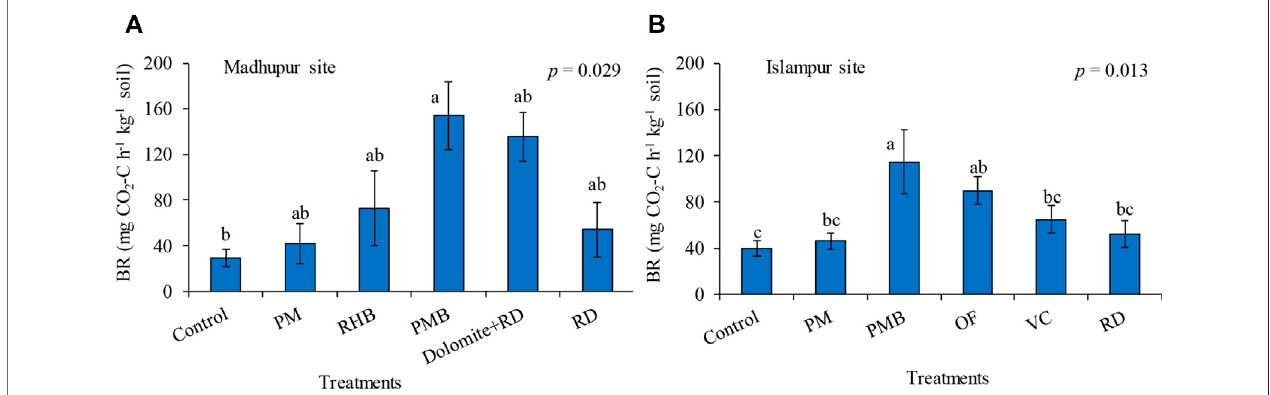
FIGURE 2 | Effects of different organic and inorganic treatments on basal respiration at Madhupur site (A) and Islampur site (B) . Data are average ± SE ( n (cid:2) 4); PM (cid:2) poultry manure, RHB (cid:2) rice husk biochar, PMB (cid:2) poultry manure biochar, RD (cid:2) recommended dose only from chemical fertilizer, OF (cid:2) compost, VC (cid:2)